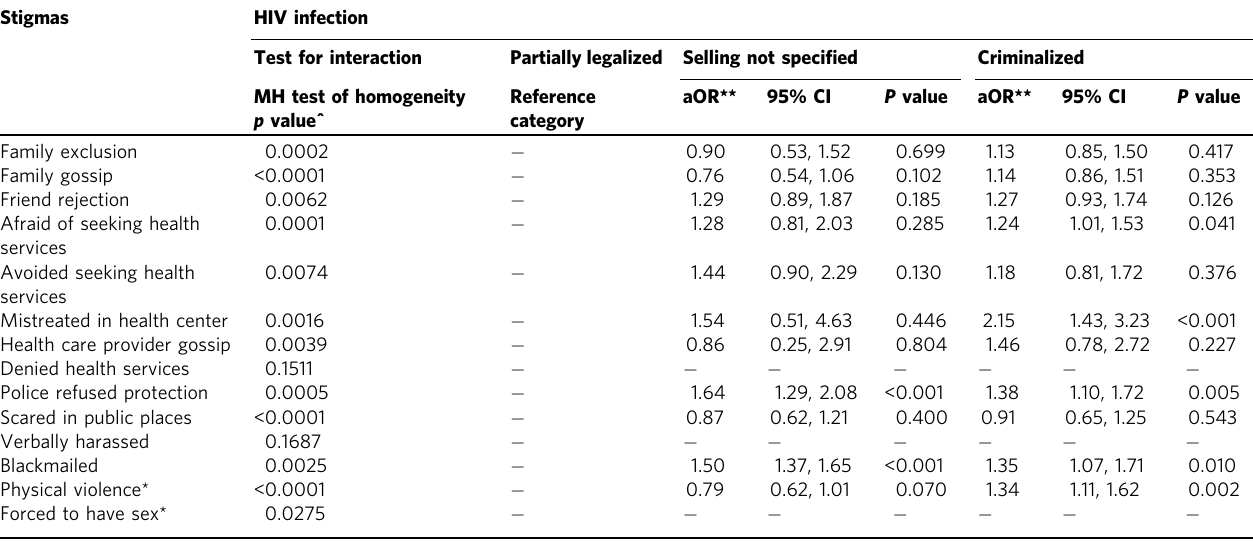
Table 6 Relationship between stigma and HIV by legal status of sex